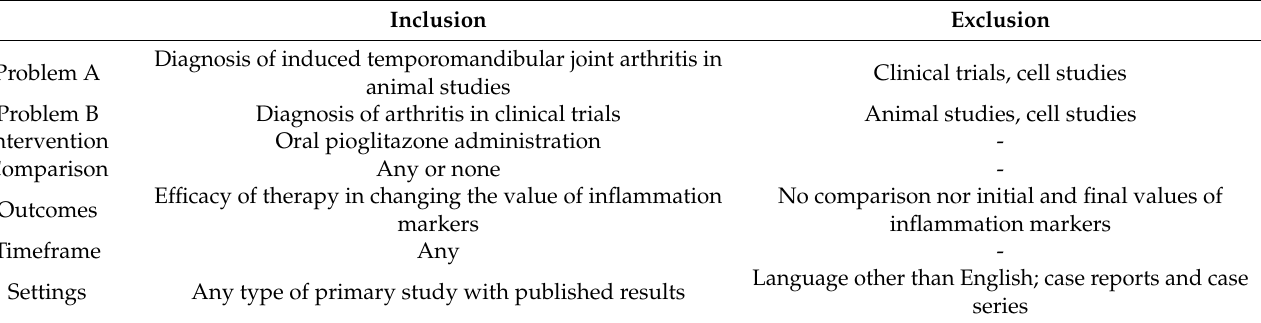
Table 1. Eligibility